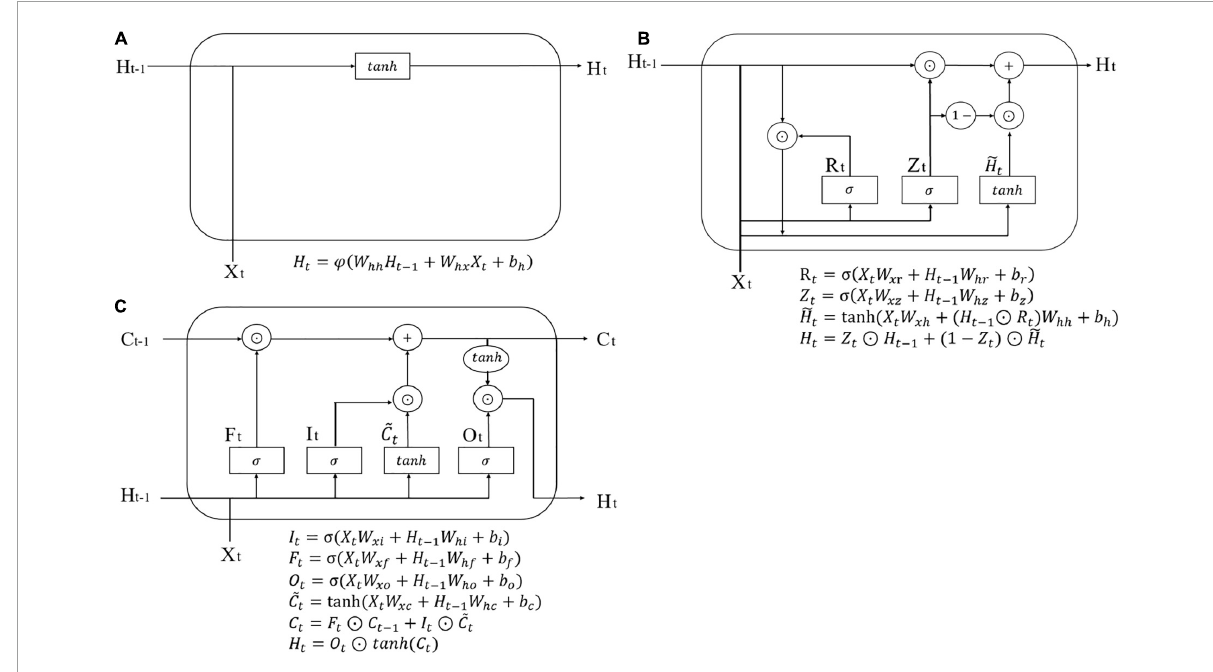
FIGURE1 Model diagram of a single cell. (A) RNN; (B) GRU; (C)